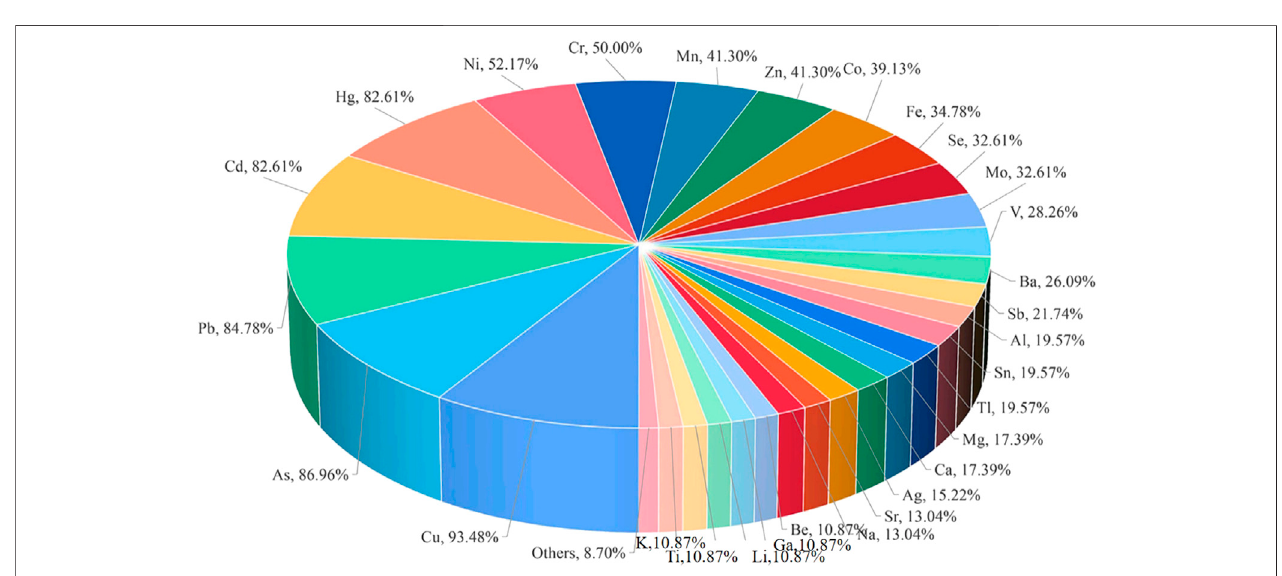
FIGURE 5 | Pie chart of elements measured by ICP-MS and their proportions in Chinese patent medicine.